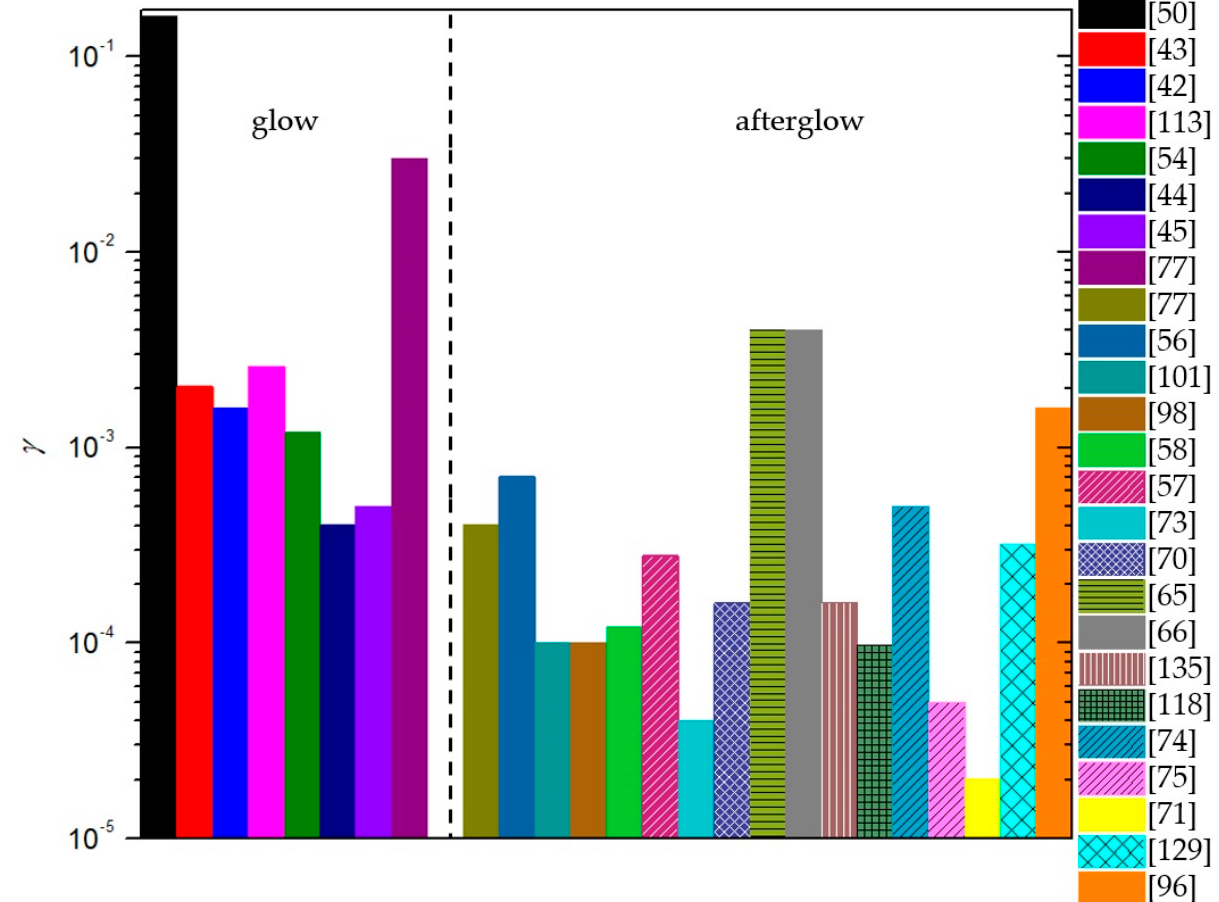
Figure 25. Compendium of γ of quartz glass measured at room temperature. Measurements in the glowing region of plasma are separated from the measurements in the afterglow.